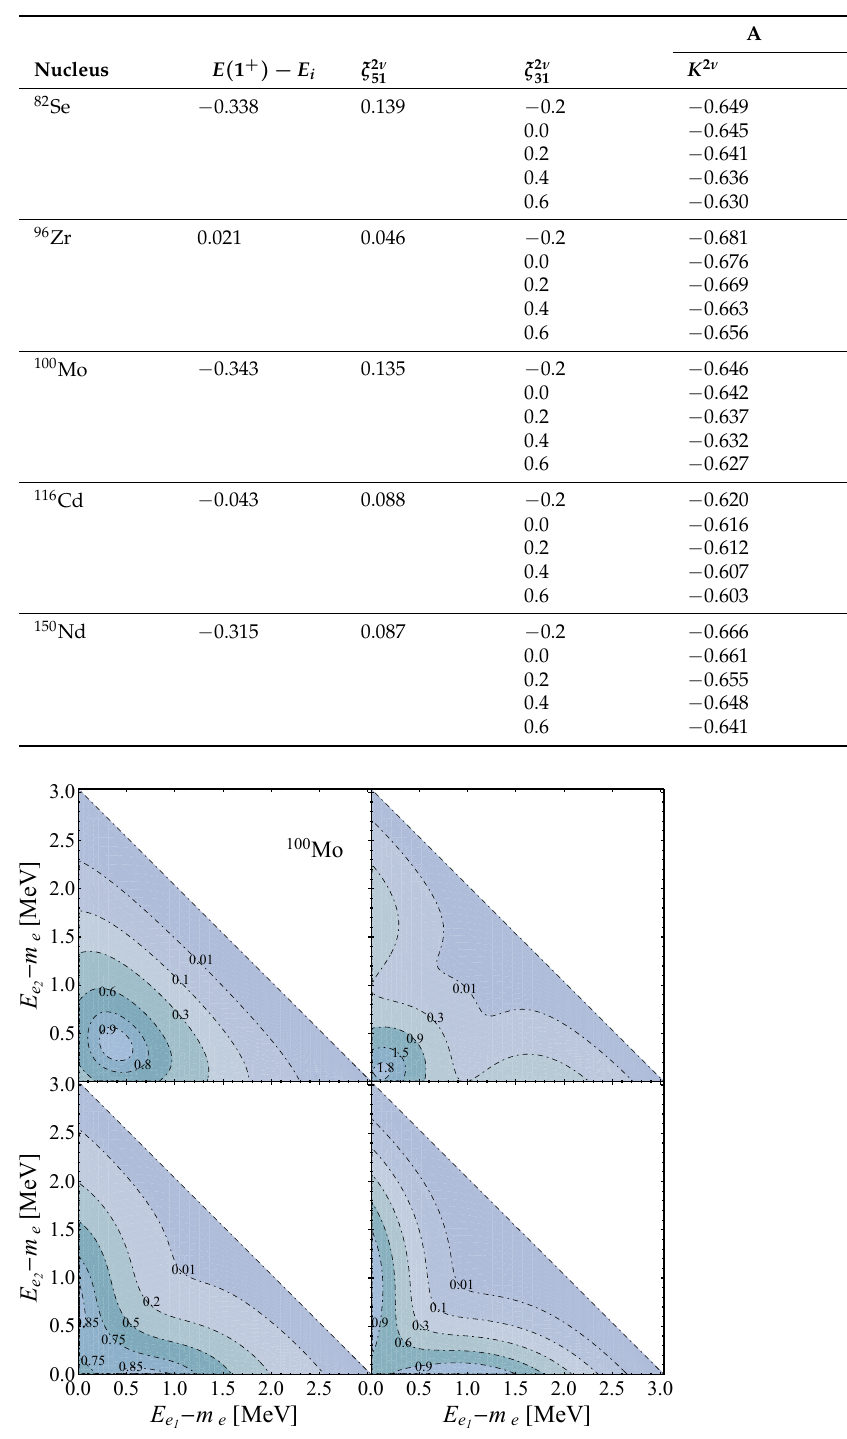
Figure 3. Normalized to unity partial double energy distributions ( 1/ Γ N )( d Γ N / ( dE e tions of the kinetic energies of the electrons, for N = 0 ( top left ), N = 2 ( bottom left ), N = 22 ( top right ) and N = 4 ( bottom right ). All distributions are in units of MeV − 2 for electrons emitted in double β decay of 100 Mo. The distributions are obtained using the screened exact finite-size Coulomb wave functions for s 1/2 electron